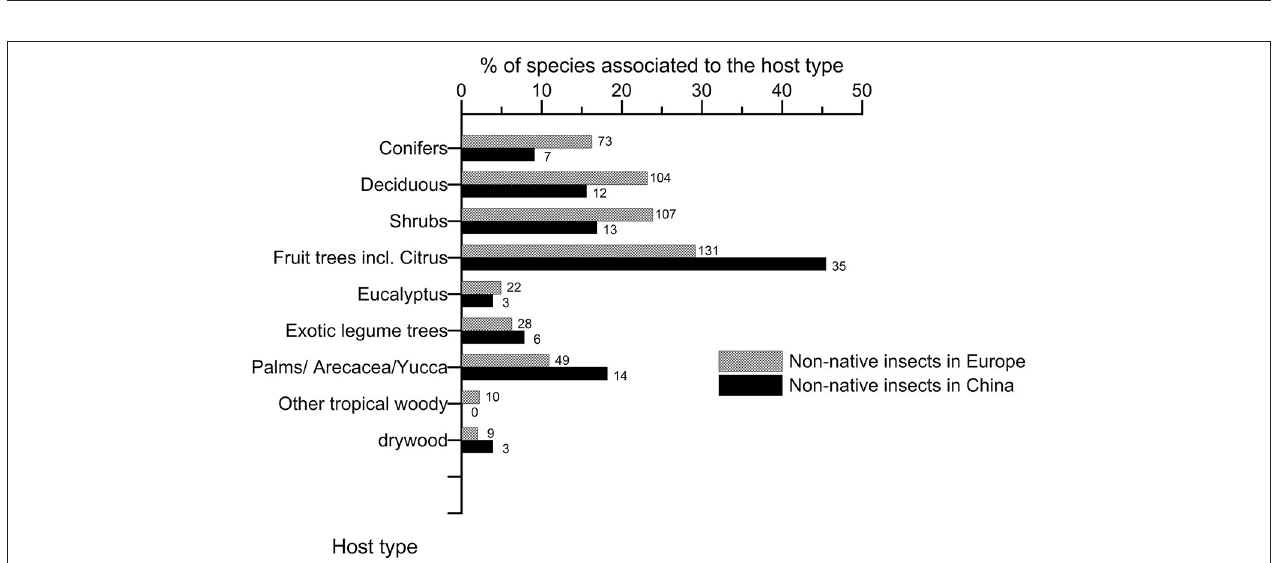
FIGURE 7 | Comparison of the host types colonized by the non-native species associated to woody plants having established in Europe and China up to 2019. The number on the right of each bar indicates the total number of non-native species observed per host type. Note that a species may colonize several types of hosts.